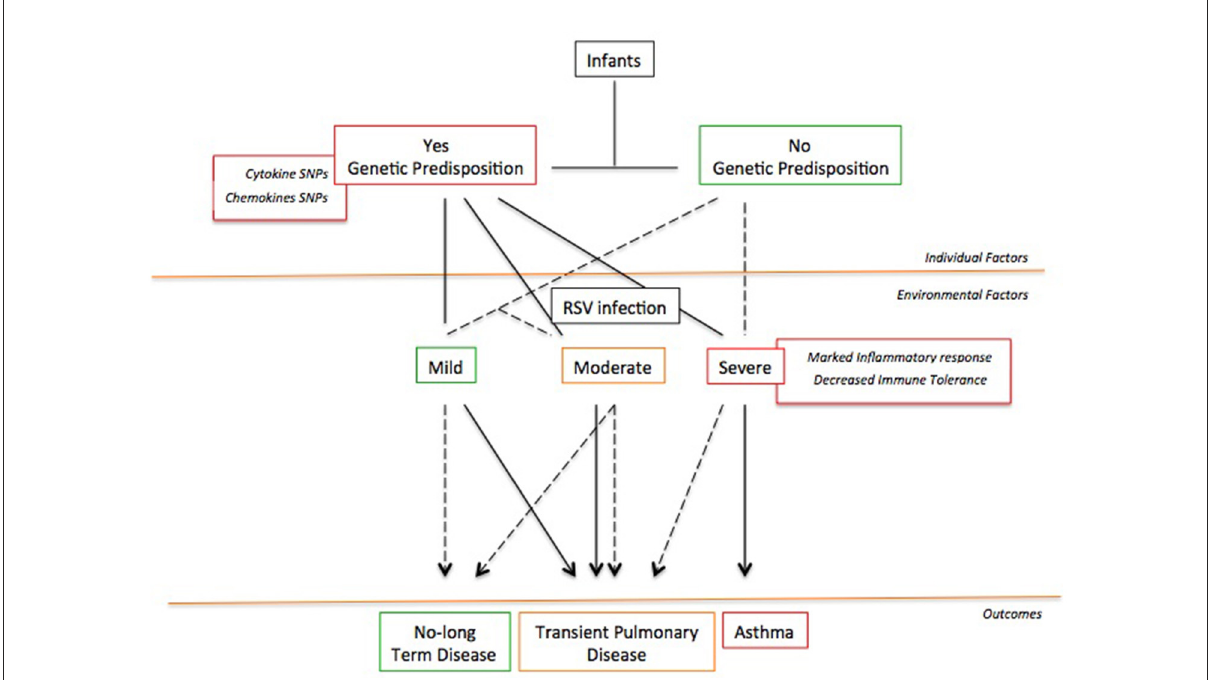
FIGURE2 The “Two-hit” hypothesis. The co-existence of at least two or more risk factors favors the asthma development following a severe RSV